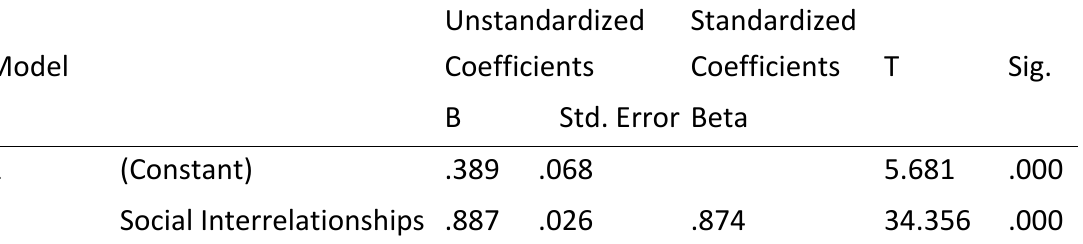
Table 8. Regression